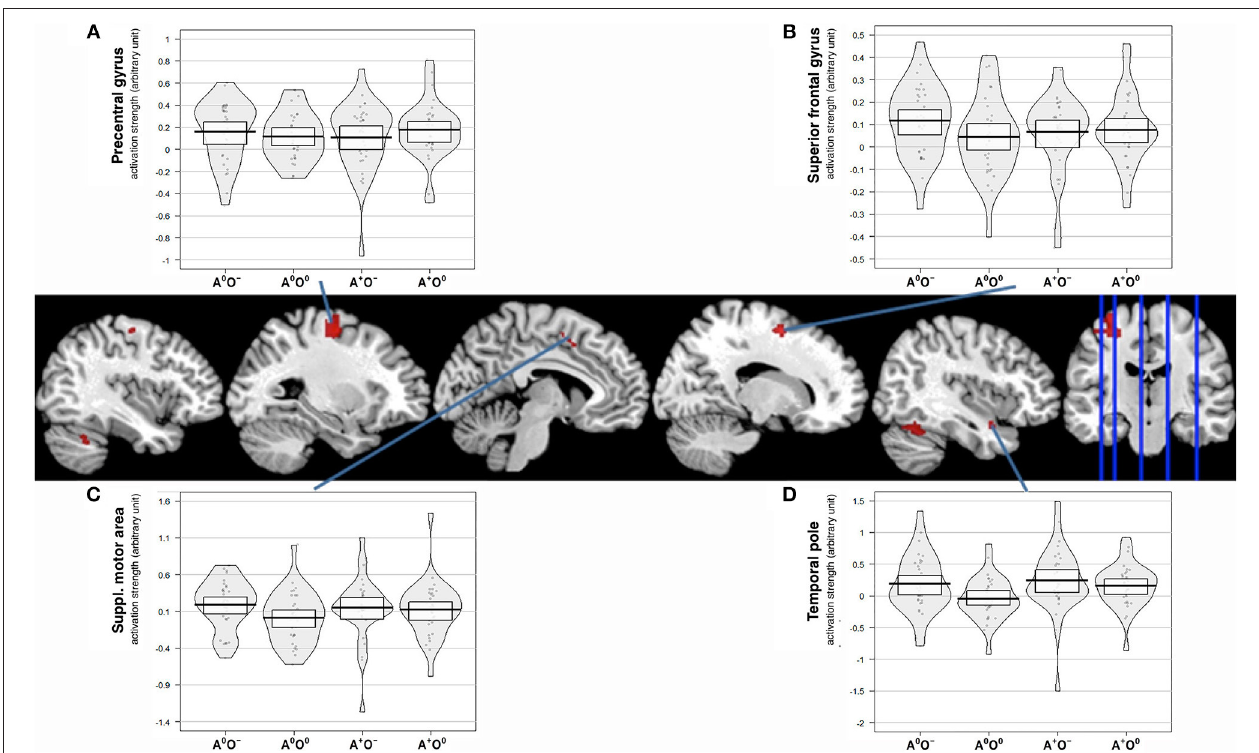
FIGURE 4 | Interaction effect of auditory and olfactory stimulation. Activation strength and BOLD responses for conjunction analysis of interaction and main effect of positive auditory during neutral olfactory stimulation, (A × O) ∩ (A + O 0 ) and negative olfactory stimulation during neutral auditory stimulation (A × O) ∩ (A 0 O − ) as well as the three-way conjunction (A × O) ∩ (A + O 0 ) ∩ (A 0 O − ), uncorr. p < 0.001. (A) displays activation strength plots of mean values extracted from the precentral gyrus (peak voxel MNI: − 26/-12/56), (B) displays activation strength plots of mean values extracted from the superior frontal gyrus (peak voxel MNI: 16/0/56) (C) displays activation strength plots of mean values extracted from the supplementary motor area (peak voxel MNI: − 8/8/44), and (D) displays activation strength plots of mean values extracted from the temporal pole (peak voxel MNI: